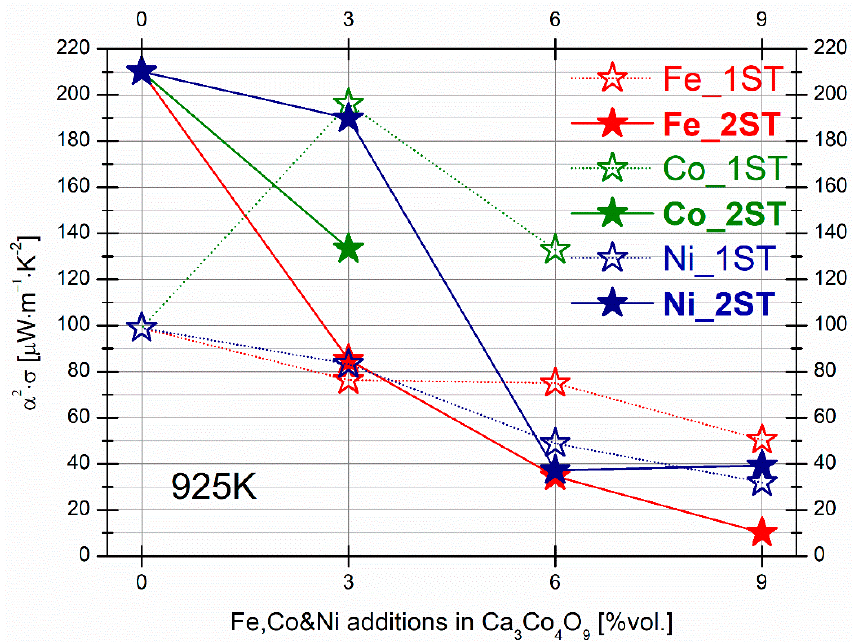
Figure 10. Compositional dependence of the power factor at 925 K, for the 1ST and 2ST sintered samples. The results for selected Co additions are shown for comparison.